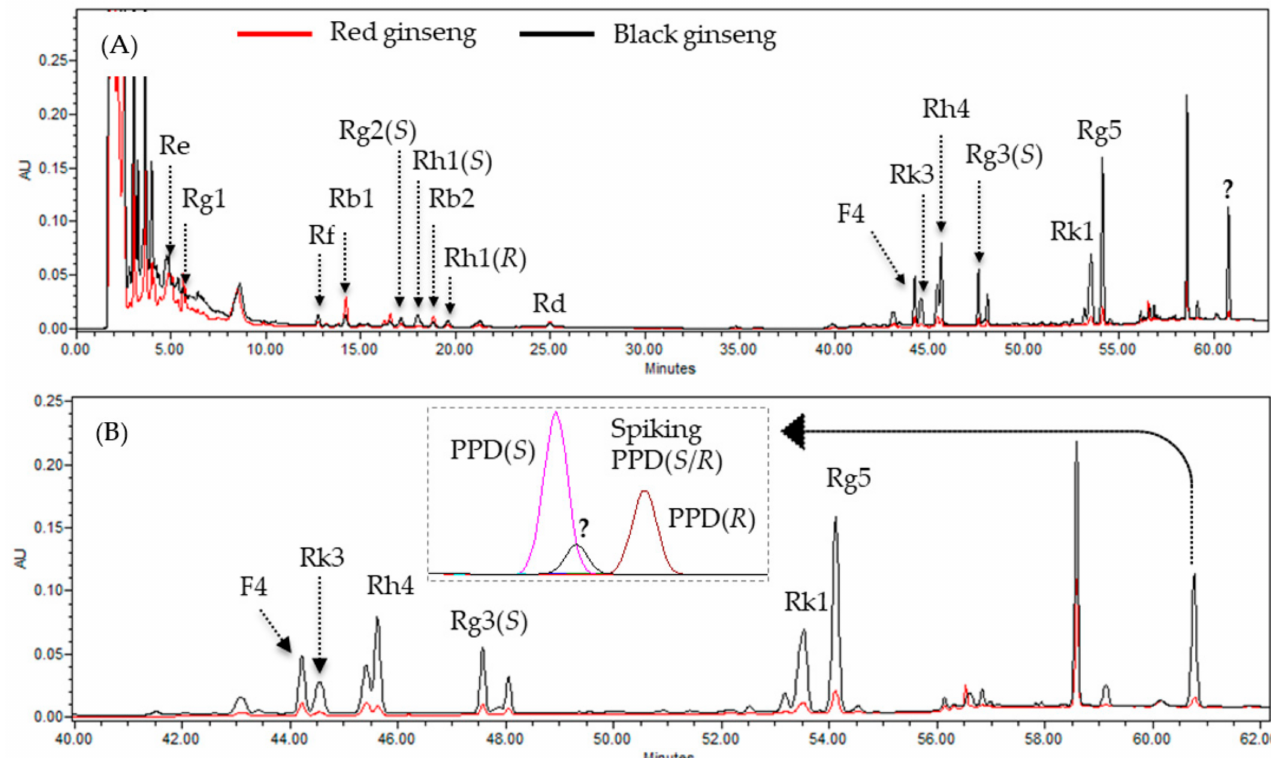
Figure 1. HPLC chromatograms of ( A ) red ginseng and black ginseng prepared after the first and ninth cycle of steaming and drying, respectively, and ( B ) a magnified chromatogram. The result of the spiking test with reference standard (PPD( S ), PPD( R )) is indicated in the dotted rectangle, and reveals that the distinctive peak (?) was not derived from